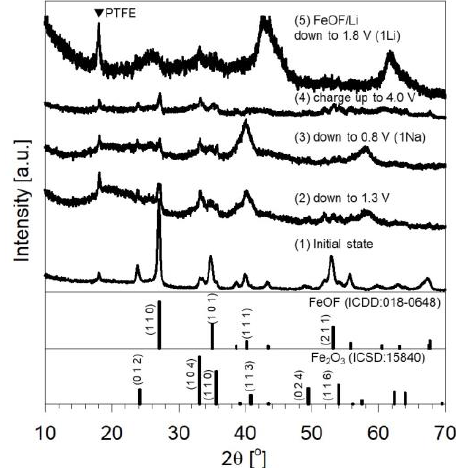
Figure 3. X-ray diffraction (XRD) patterns of FeOF cathode pellets (1) at the initial state, (2) discharged down to 1.3 V, (3) discharged down to 0.8 V (1 Na discharge), and (4) charged up to 4.0 V after 1 Na discharge. The XRD pattern of (5) electrochemically synthesized LiFeOF is presented as a reference.